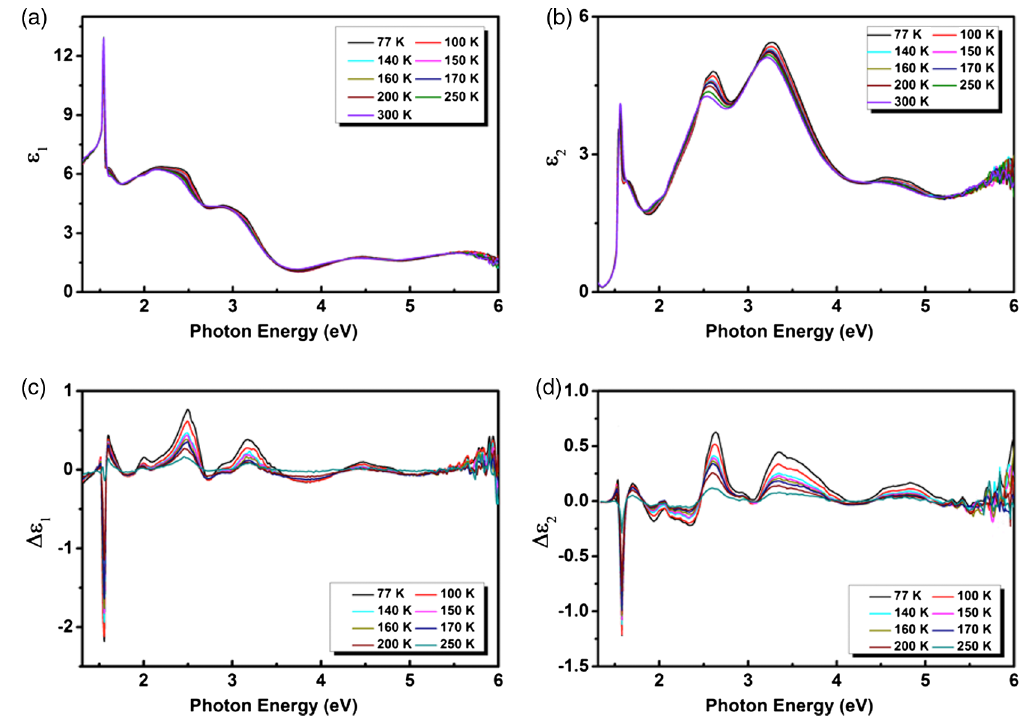
FIG. 2. (a) The real ( ε 1 ) and (b) imaginary ( ε 2 ) parts of the dielectric function of FA 0 ellipsometry data as a function of temperature. The difference in the (c) real and (d) imaginary parts of the dielectric function between room temperature and colder